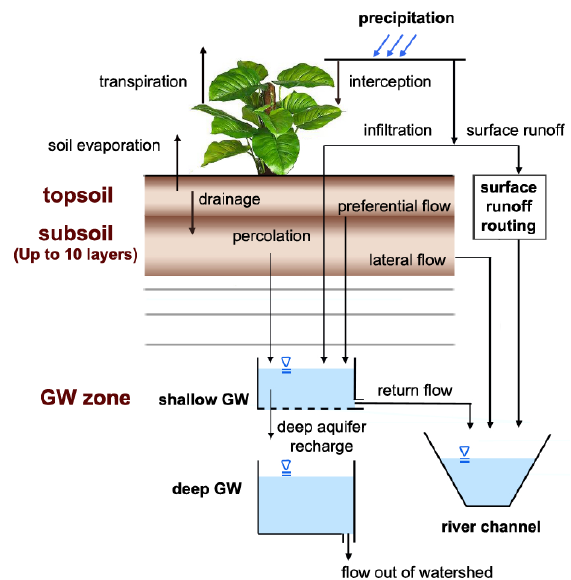
Figure 2. Schematic overview of available pathways for water movement in the land phase of the SWAT model. GW, groundwater.